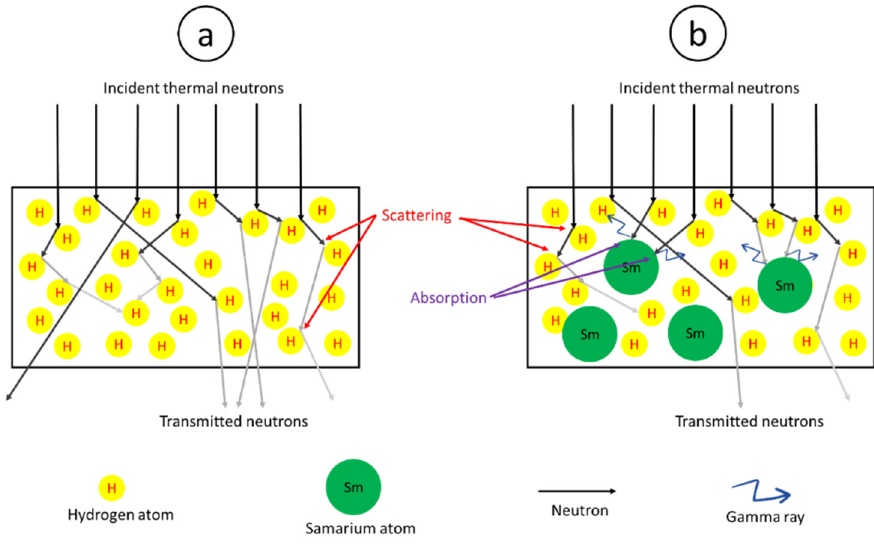
Figure 1. Scheme showing mechanisms of thermal neutron attenuation of ( a ) neat UHMWPE and ( b ) Sm 2 O 3 /UHMWPE composite.